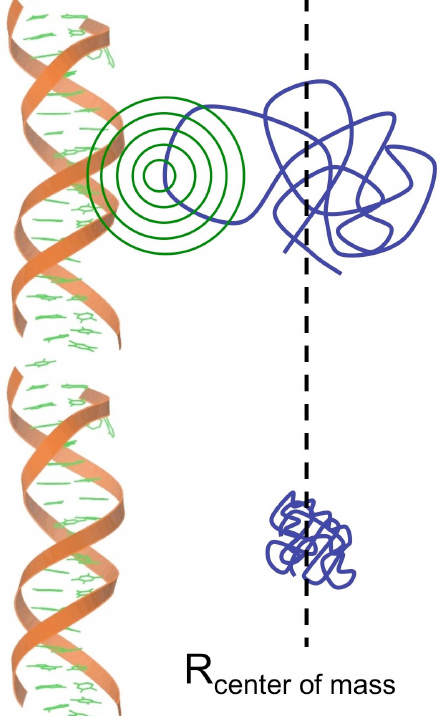
Figure 1. A cartoon representing the increase in the kinetics of the binding process due to fly-casting mechanism (adapted from Shoemaker et al .